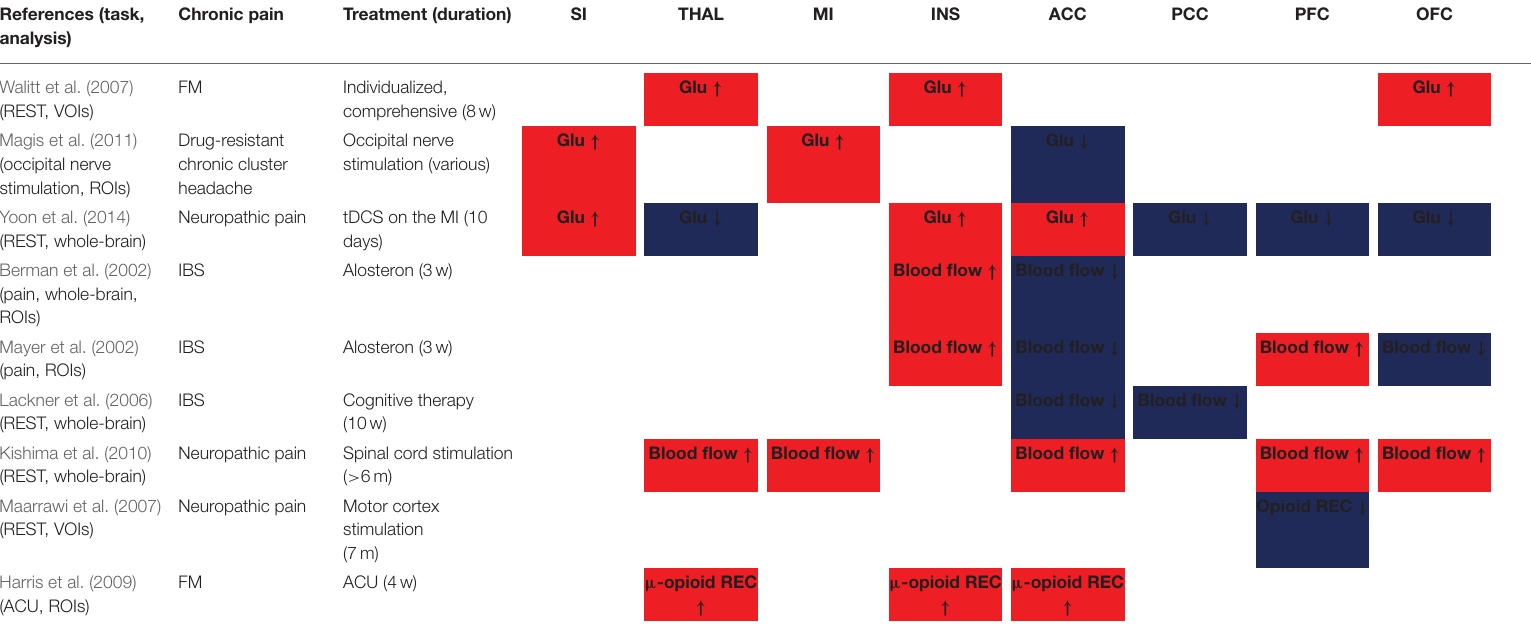
TABLE 2 | Summary of metabolic changes (pre-treatment vs. post-treatment) in the PET studies. References (task,